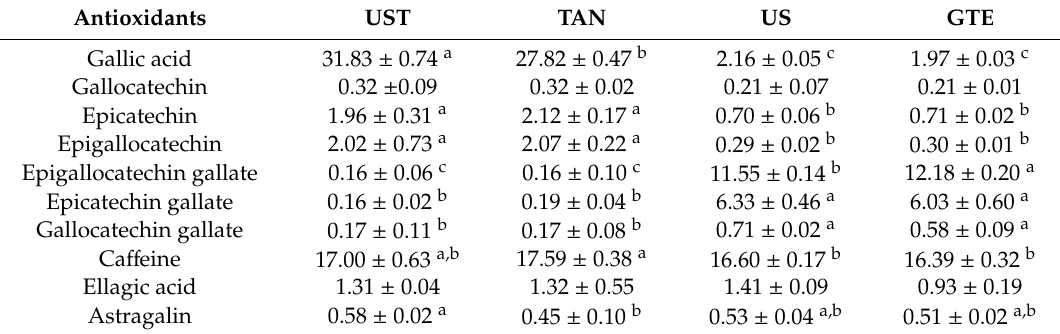
a,b,c Data between groups were significantly di ff erent ( p <